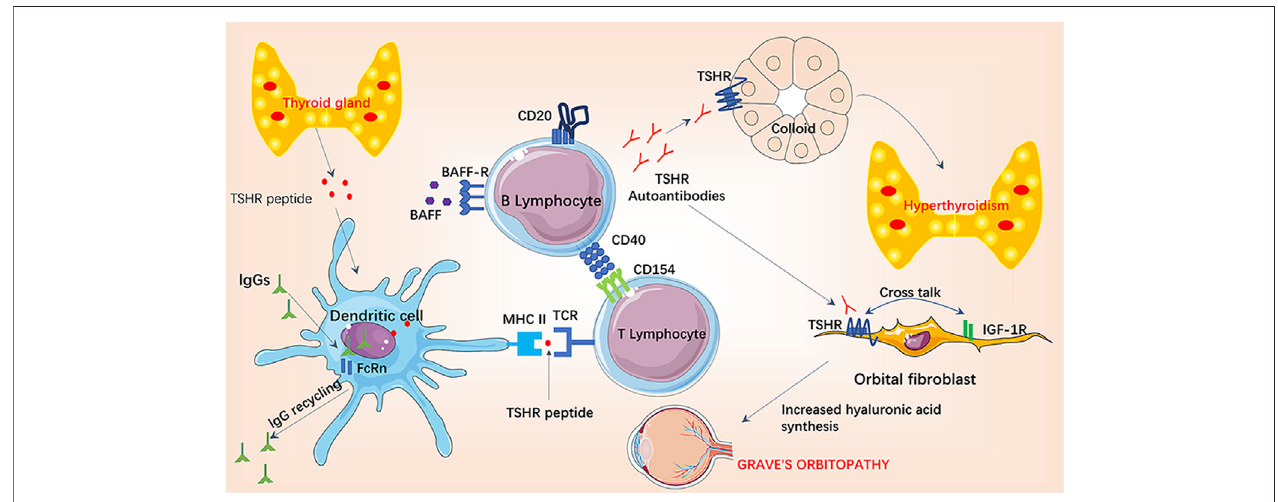
FIGURE 1 | Pathogenesis of Graves ’ hyperthyroidism and Graves ’